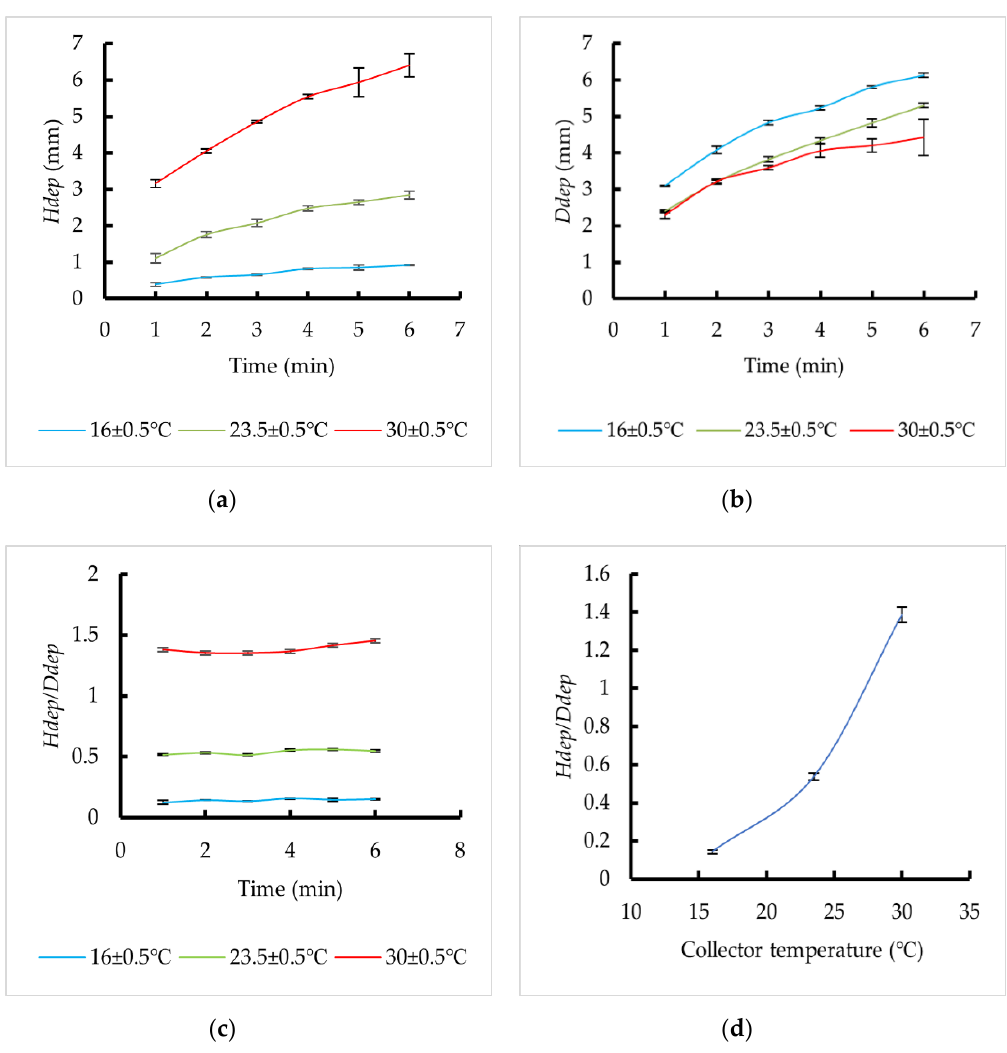
Figure 4. Effect of deposition time and collector temperature on the formation of fiber accumulation Figure 4. E ff ect of deposition time and collector temperature on the formation of fiber